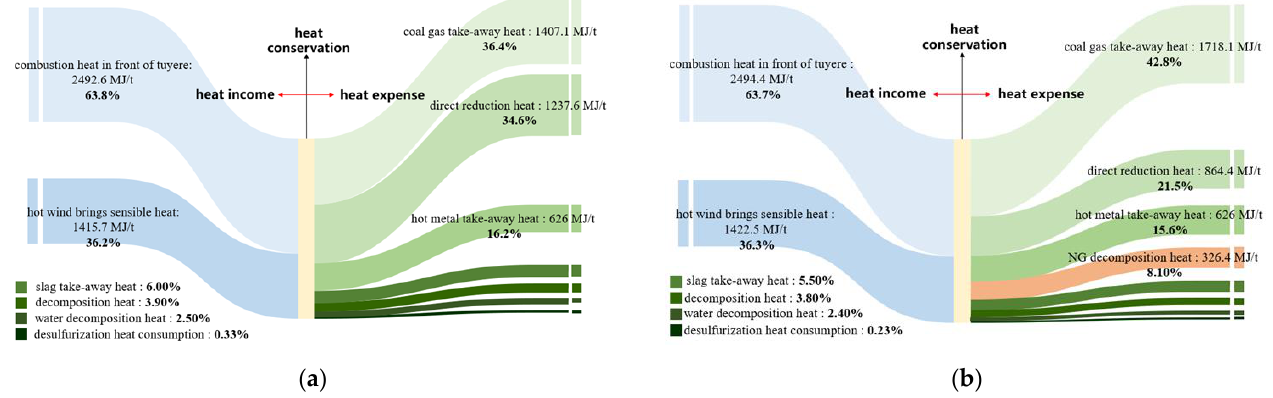
Figure 2. Heat balance in the high temperature zone for base case ( a ) and injection of 100 m 3 /t NG conditions without thermal compensation ( b ).